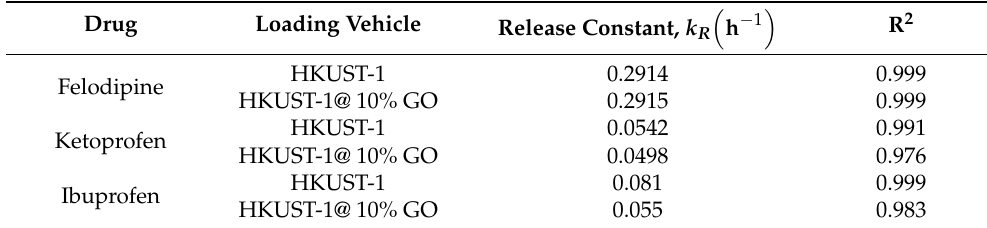
Figure 8. Drug release kinetics of drugs onto HKUST-1/GO composite materials: ( a ) felodipine ( b ) ketoprofen ( c ) ibuprofen. Table 3. Summary of drug release kinetics parameter of different BSC II drugs from GO, MOF, and